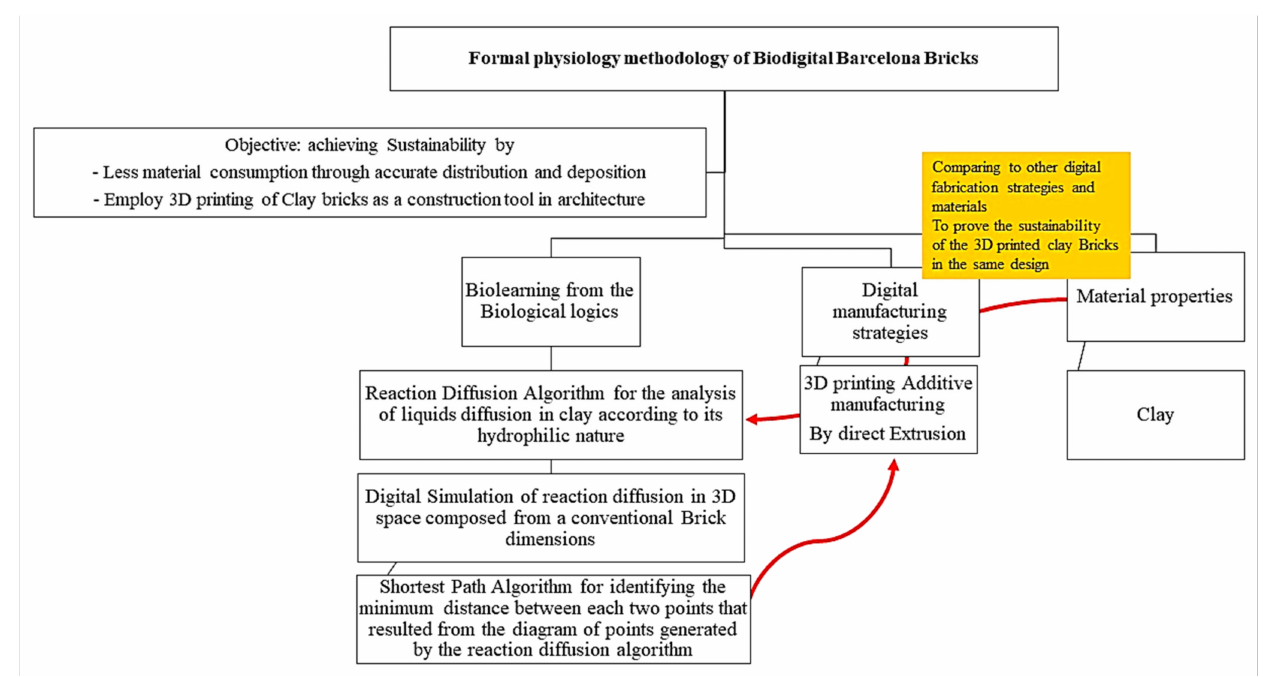
Figure 3. Methodology of achieving Formal Physiology of the 3D printed Biodigital Barcelona Clay